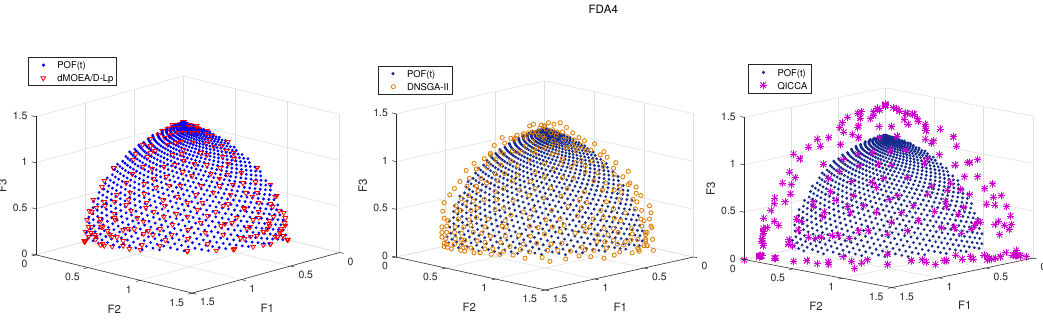
Figure 6. Solution sets obtained by three algorithms at different times on FDA3 in case of τ T = 35, n T = 5.